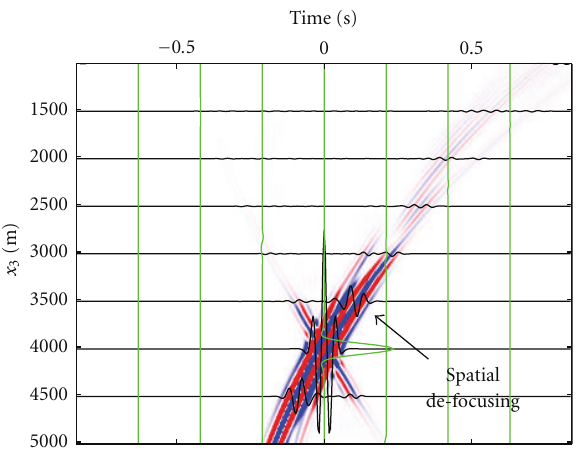
Figure 27: PSF for a virtual source at x A = (15000m,4000m) for a model with varying source spectra; the red-blue plot is clipped at 20% of the maximum amplitude; the black and green traces represent true-amplitude temporal and spatial traces, respectively.